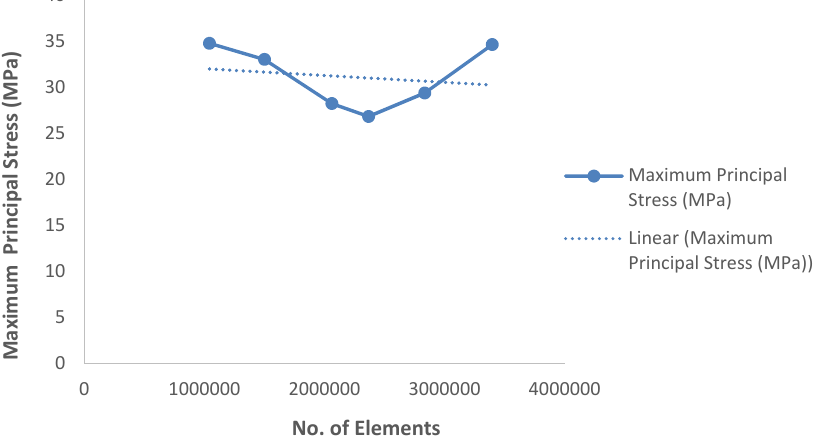
Table 1. Material properties attributed to various components in the model.